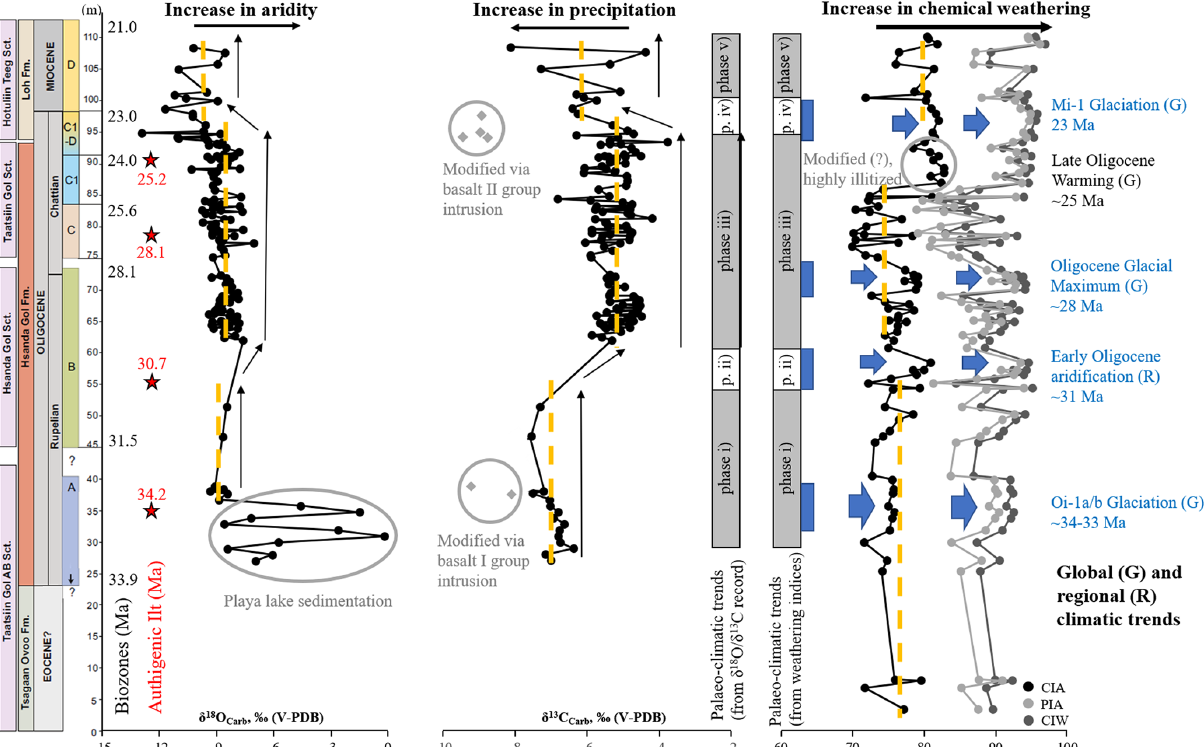
Figure 8. Lithostratigraphic framework of the sediments from the Valley of Lakes (Mongolia, Central Asia) showing the biozonation (modi- fied after Harzhauser et al., 2017) and formation ages of the authigenic illitic (Ilt) phases obtained in this study (red asterisks), as well as soil carbonate δ 18 O and δ 13 C isotope profiles and shifts in the silicate mineral-derived chemical weathering indicators. Note that these hydrocli- mate proxies are inversely correlated and follow long-term trends (indicated by orange dashed lines) in aridification or increases in humidity in this region (indicated by black arrows). Increased chemical weathering degrees (highlighted using blue bars and blue arrows) coincide with glaciation events documented in time-equivalent marine deep-sea deposits (Zachos et al., 2001; Gallagher et al., 2020). Samples and intervals outlined by grey circles are most likely modified due to the flows of the basalt I and II groups or local strong illitization and are, therefore, excluded from the palaeo-climatic